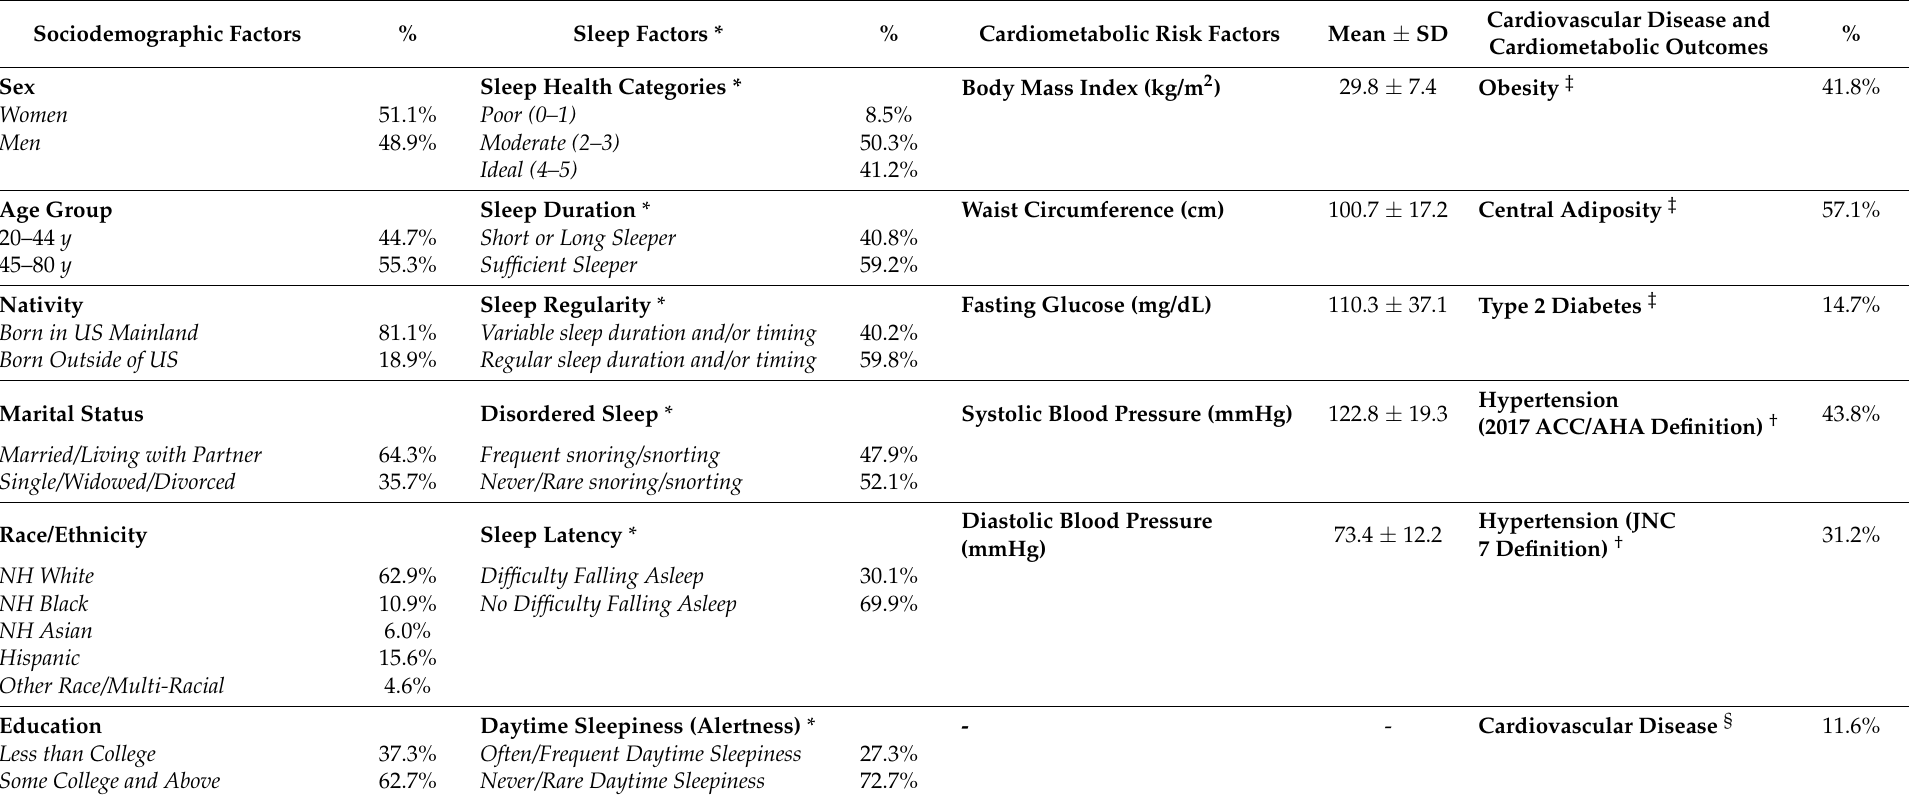
Table 1. Descriptive Characteristics of the Study Population (n =